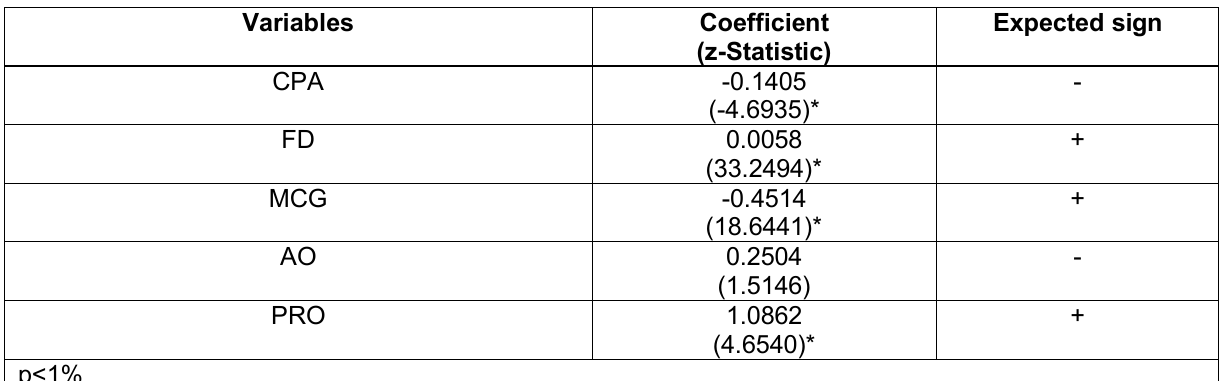
Table 4.The Result of Hypothesis